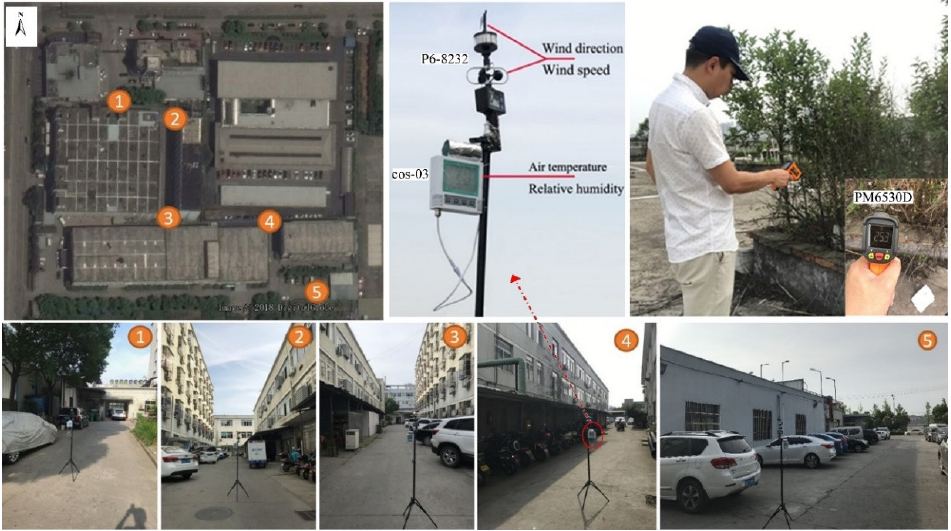
Figure 5. On‐site field measurement and the spatial distribution of test points.